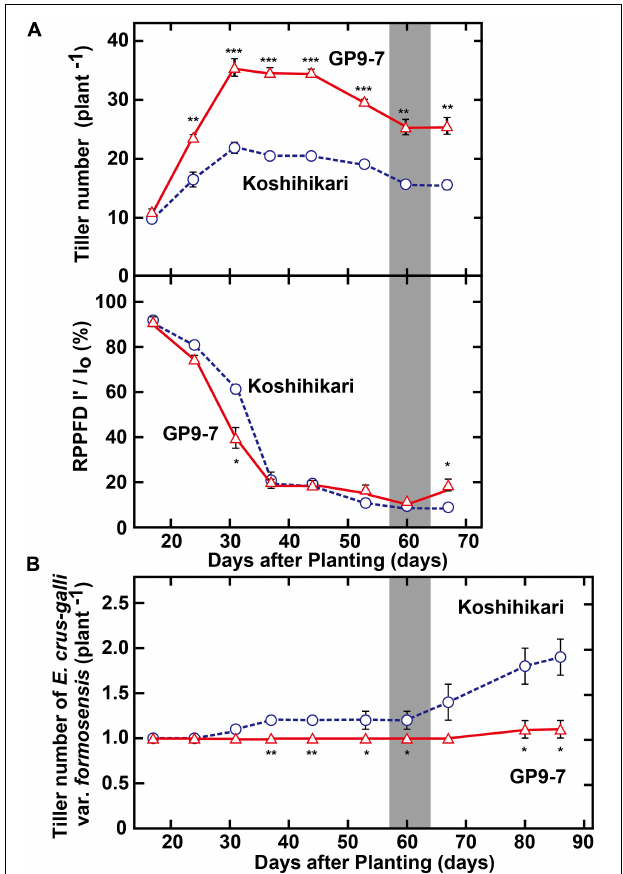
FIGURE 5 | Weed suppression-related properties of GP9-7. (A) Developmental transitions in tiller numbers and the RPPFD at ground level of Koshihikari and the GP9-7 in the test field in Fukuyama, Japan in the summer of 2019 (planting date: June 15, 2019). The periods for heading are indicated by vertical gray bars. (B) Developmental transitions in tiller numbers of the transplanted weed, E. crus-galli var. formosensis under the canopy formed by rice stands. Symbols, ***, **, and * indicate statistically significant differences compared to Koshihikari at P < 0.001, P < 0.01, and P < 0.05, respectively, calculated by the Student’s t -test. Values for Koshihikari are indicated with blue circles with broken lines and values for GP9-7 are represented with red triangles with solid